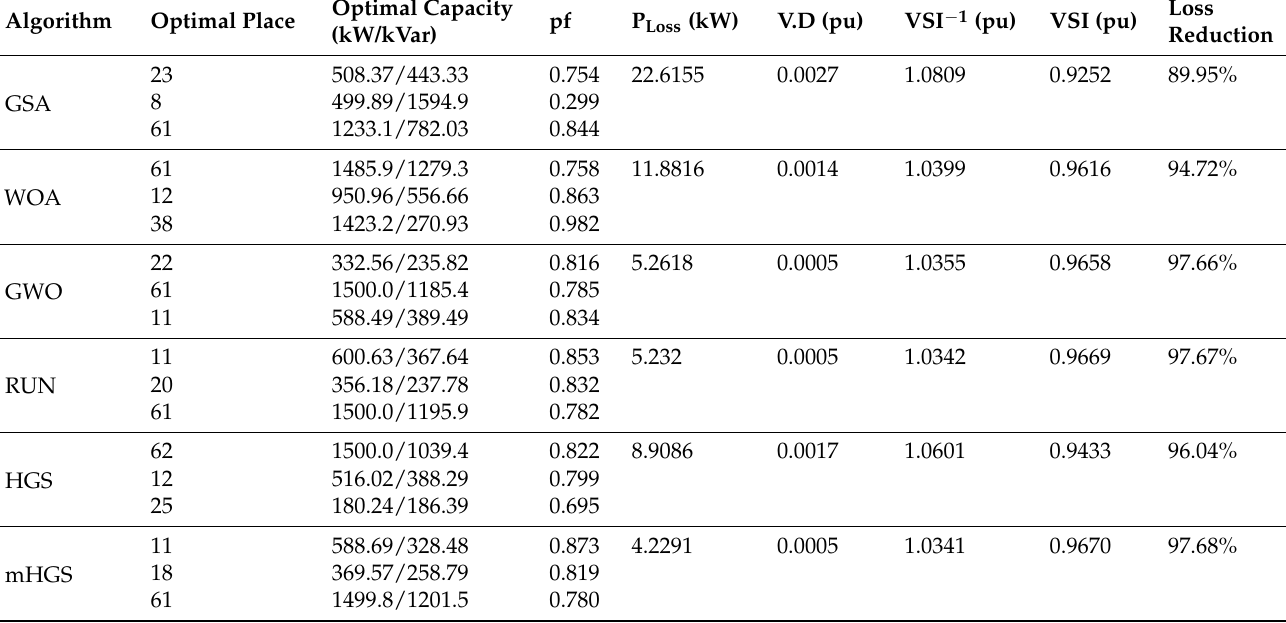
Table 7. The resulting optimal values through different optimizers applied to the IEEE